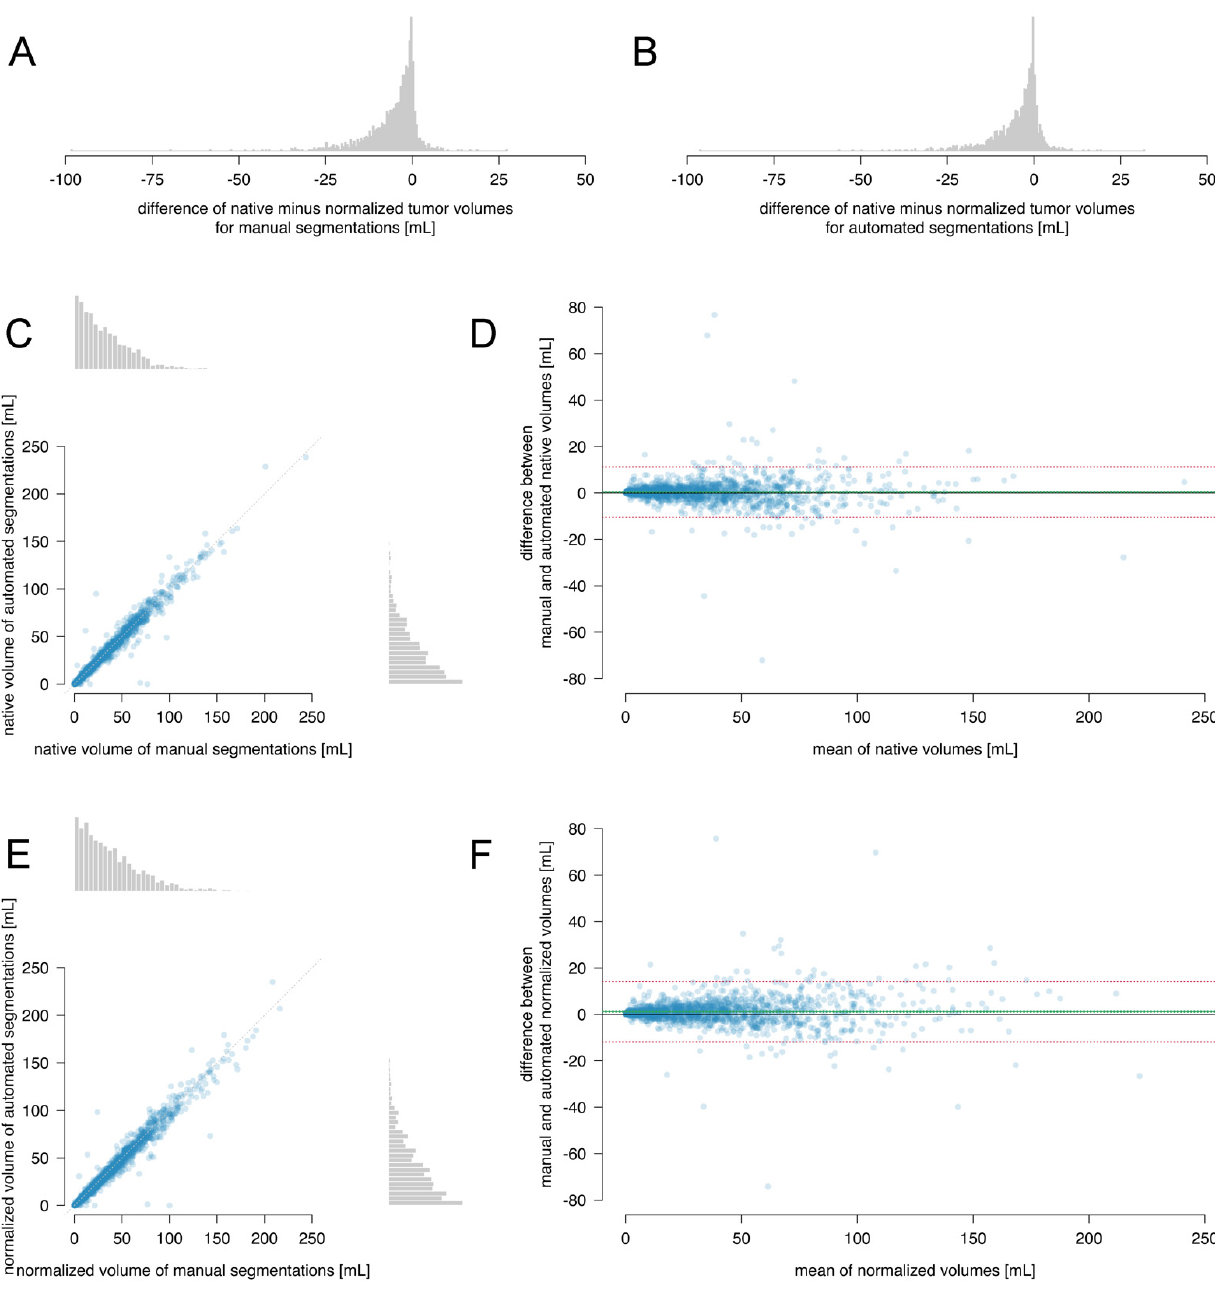
Figure 2. Comparison between manual and automated segmentations: ( A ) a histogram of absolute difference for the manual segmentations and ( B ) for the automated segmentations, ( C ) a correlation plot of the native tumor volumes with histograms in the margin, ( D ) a Bland–Altman plot for the native tumor volumes, ( E ) a correlation plot of the normalized tumor volumes with histograms in the margin, and ( F ) a Bland–Altman plot for the normalized tumor volumes. Each dot represents the volumes of one patient. The dotted diagonal in ( C ) and ( E ) indicates the identity line. The bias is plotted as solid green line with 95% CI as dotted green lines and the limits of agreement as dotted red lines in ( D ) and ( F ). This indicates excellent agreement, consistency, and equivalence in native and normalized tumor volume measurements between the automated and manual segmentations.